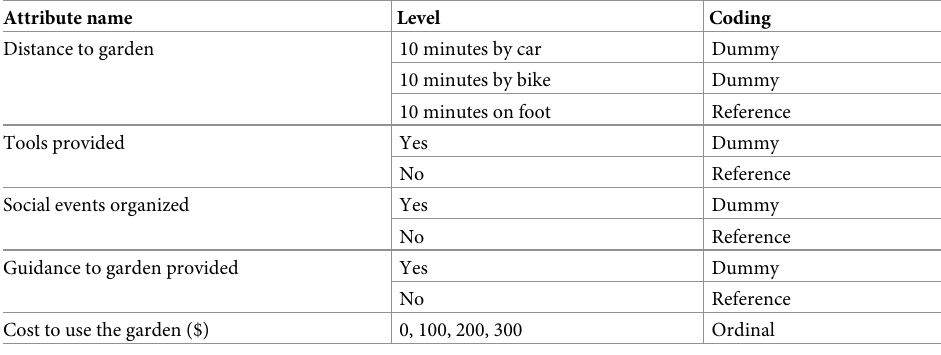
Table 2. Attributes and their levels.